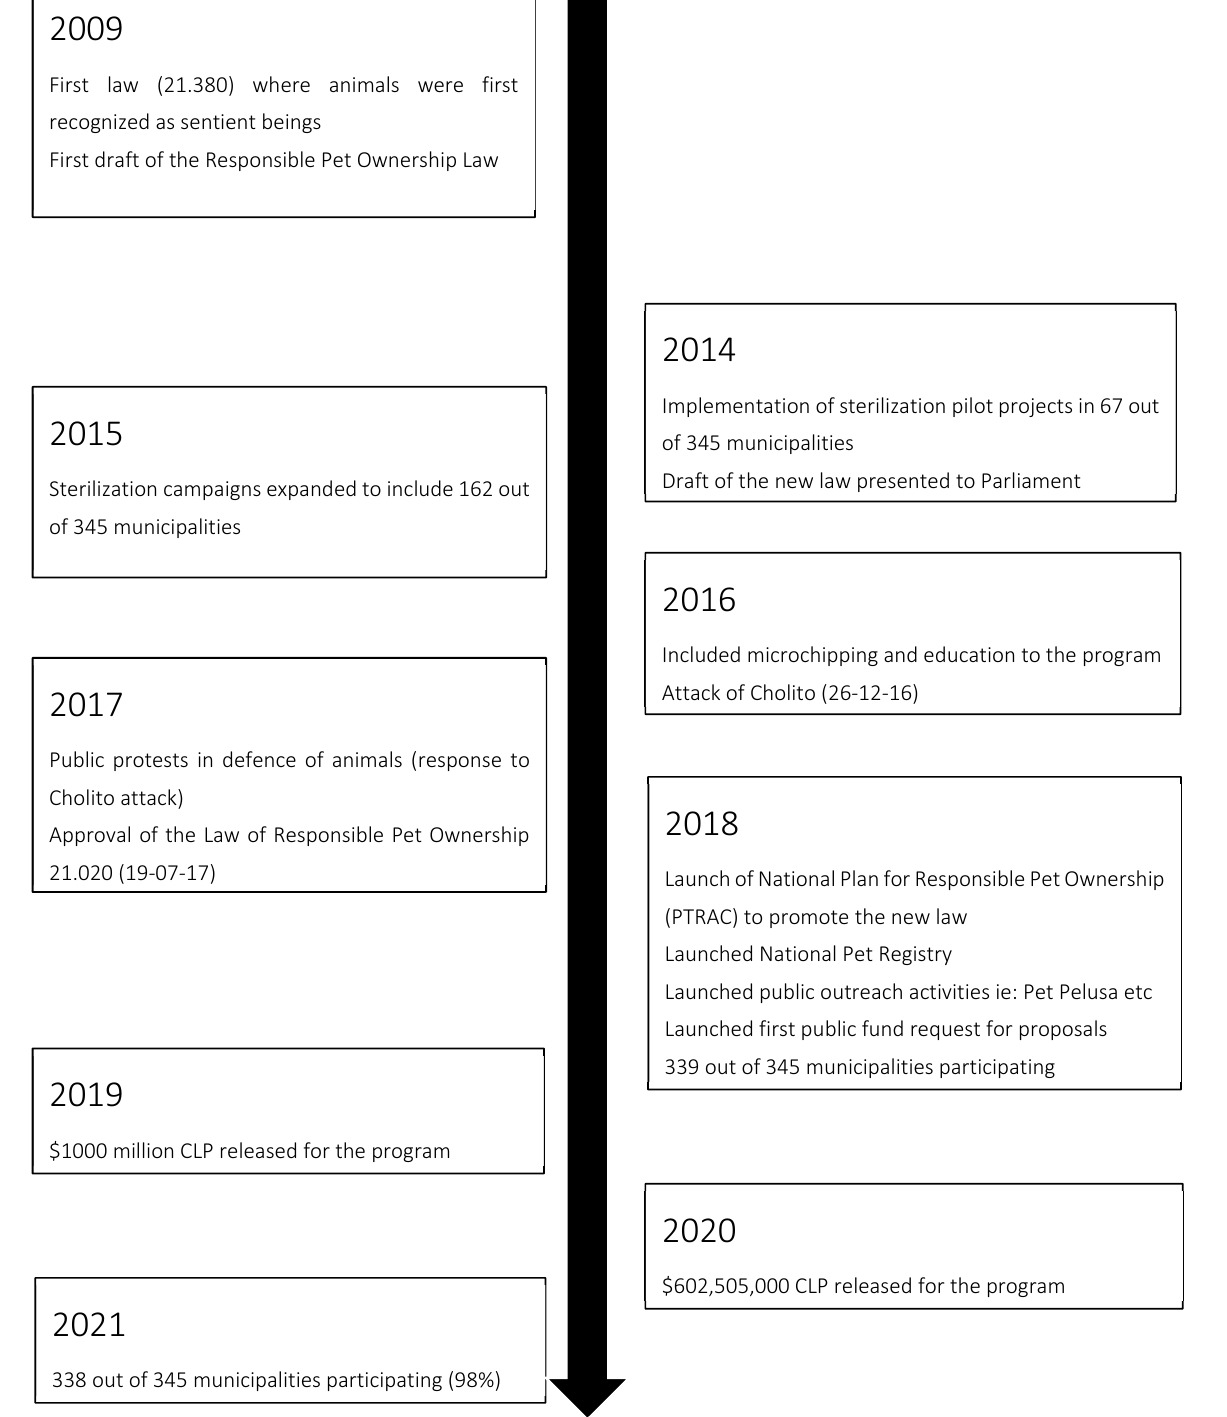
Figure 1. Timeline of important landmark events in the formation and implementation of the National Program for the Responsible Ownership of Companion Animals (PTRAC in Spanish: Programa Tenencia responsible para Animales de Compañía) between 2009 and 2021.